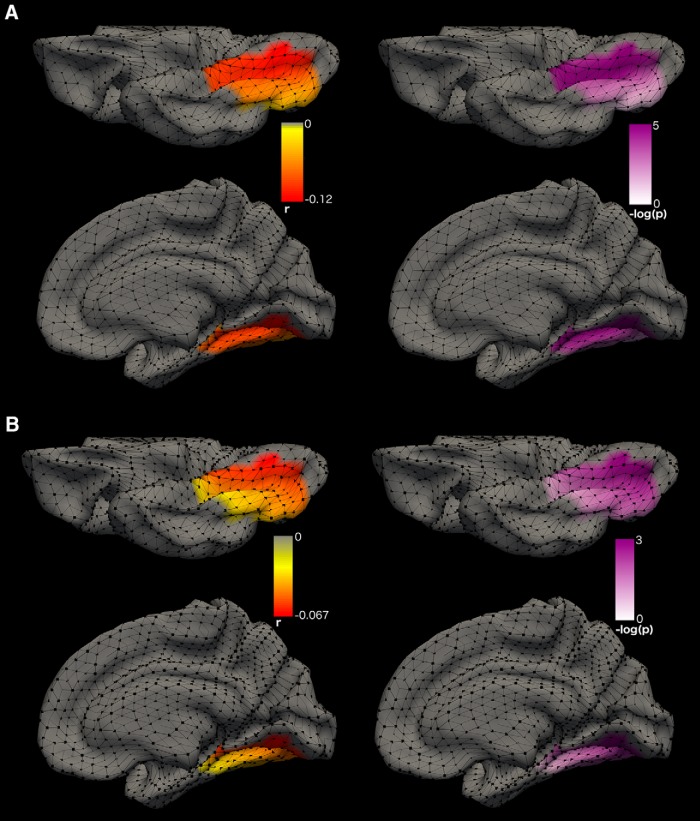
Vertex-wise phenotypic association of SA with anxiety-depression scores within cluster 6R. Bottom view (top) and medial view (bottom) of the right hemisphere. The left panels show the cubic effect sizes (correlations) for each vertex of the 6R cluster for SA (94 vertex). The right panels show the significance (p value) of the association in –log10 scale. Vertices represent the intersections of the triangular mesh reconstructed by FreeSurfer to model cortical surfaces. A, Vertex-wise association between SA and anxiety-depression (SPHERE score) in the QTIM sample (n = 833). The significance threshold of 4.2E-4 is reached for p > 3.4 in the log scale. B, Vertex-wise association between SA and anxiety-depression (DSM-oriented score) in the HCP sample (n = 890).